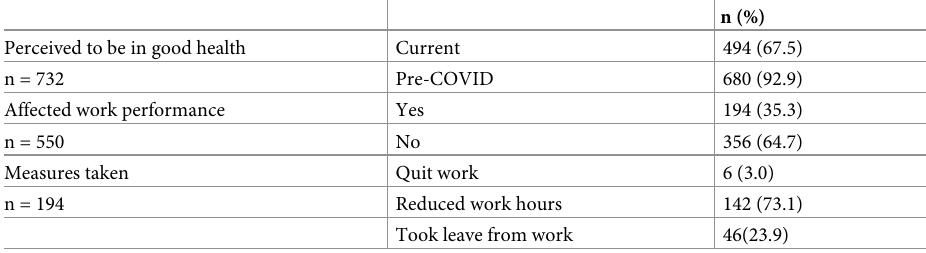
Table 3. Perceived health and work productivity among Long COVID